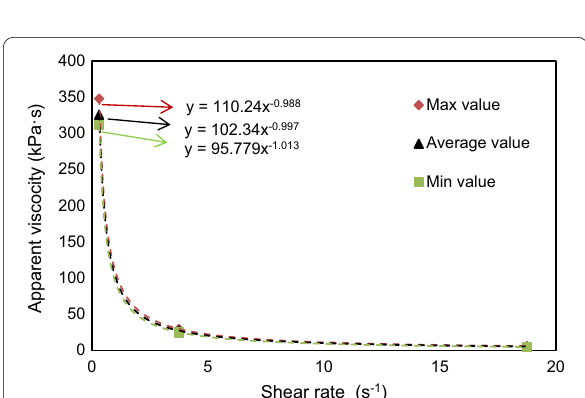
Fig. 7 Relationship between the shear rate and the apparent viscosity